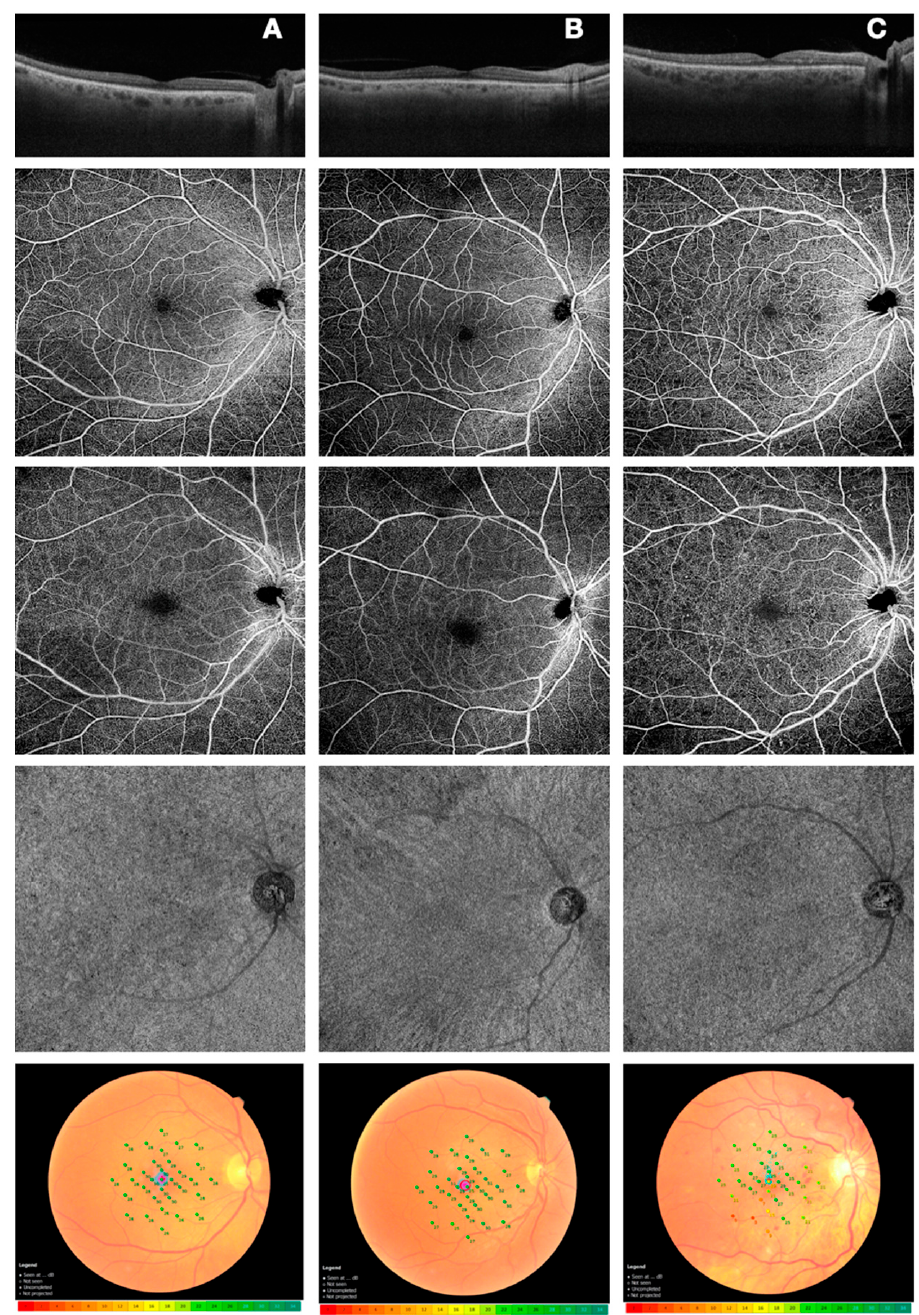
Figure 1. Comparison of OCT (first line), widefield OCTA (SCP, second line; DCP, third line; CC, third line), and microperimetry (fourth line) among the three groups (healthy ( A ); DM without DR ( B ); DM with NPDR, ( C )). Abbreviations: OCT, optical coherence tomography; OCTA, optical coherence tomography angiography; SCP, superficial capillary plexus; DCP, deep capillary plexus; CC, choriocapillaries; DM, diabetes mellitus; DR, diabetic retinopathy; NPDR, nonproliferative diabetic retinopathy.